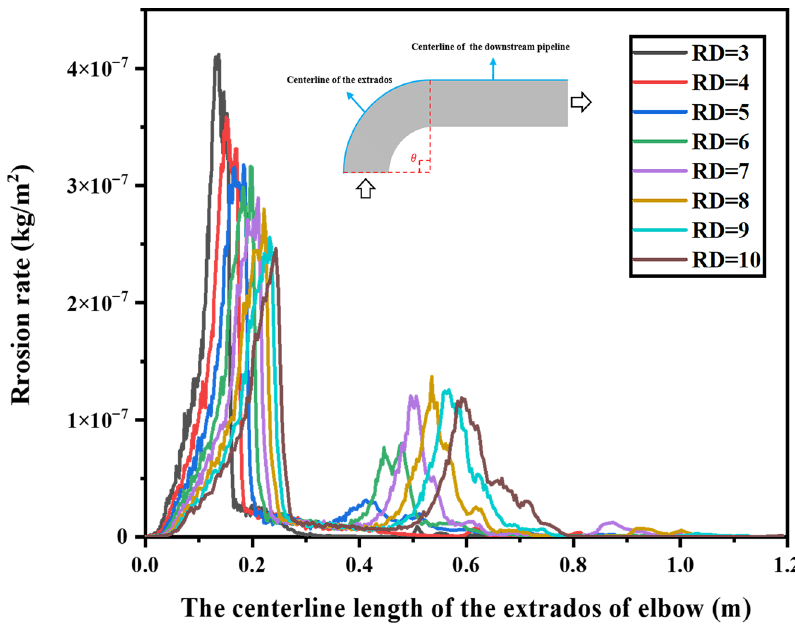
Figure 17. Erosion data from external arch of bent pipe to the centerline of downstream straight pipe with different curvature ratios.